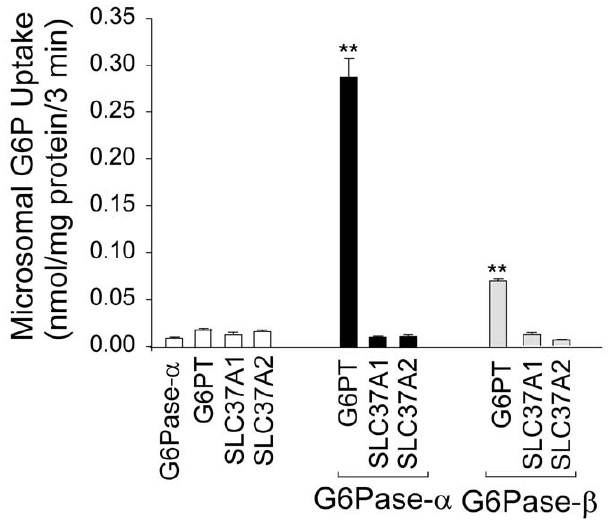
Figure 5. Effects of G6Pase- a and G6Pase- b on microsomal G6P transport activity of SLC37A1, SLC37A2 and G6PT. Microsomal membranes were isolated from COS-1 cells infected with Ad-G6Pase- a , Ad-G6PT, Ad-SLC37A1-5Flag, or Ad-SLC37A2-5Flag, co-infected with Ad-G6PT/Ad-G6Pase- a , Ad-SLC37A1-5Flag/Ad-G6Pase- a , or Ad- SLC37A2-5Flag/Ad-G6Pase- a , or co-infected with Ad-G6PT/Ad-G6Pase- b , Ad-SLC37A1-5Flag/Ad-G6Pase- b , or Ad-SLC37A2-5Flag/Ad-G6Pase- b as described in Materials and Methods. Results represent three independent experiments, with each data point determined in triplicate. Data are presented as the mean 6 SEM. ** p , 0.005.